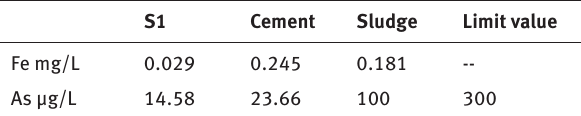
Table 4: TCLP test results for modified